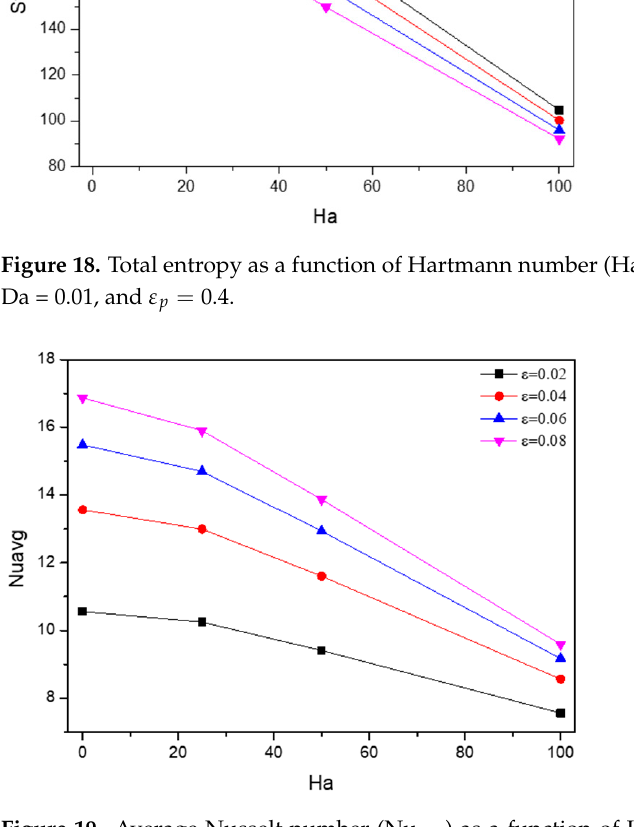
Figure 19. Average Nusselt number (Nu ave ) as a function of Hartmann number (Ha) at various values of porosity ε p . Ra = 10 6 , φ = 0.02, and Da = 0.01.